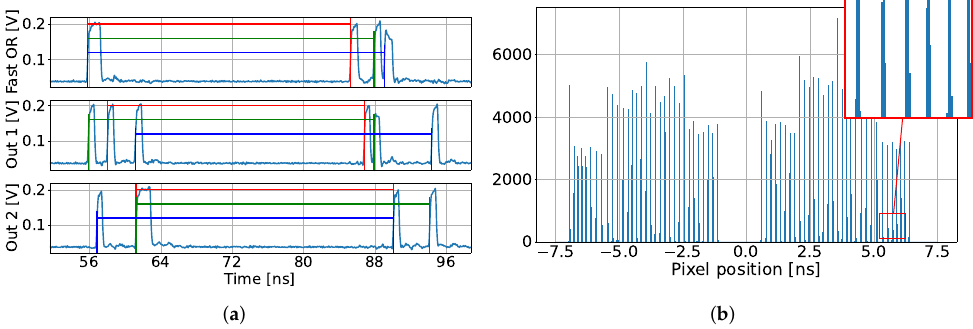
Figure 6. ( a ) FASTPIX event with 3 pixel hits. Matching pairs of pulses are connected with a line. ( b ) Pixel position along the delay lines for single-pixel events. The delay line is connected to two groups of 32 pixels each, with a gap of 8 pixels in